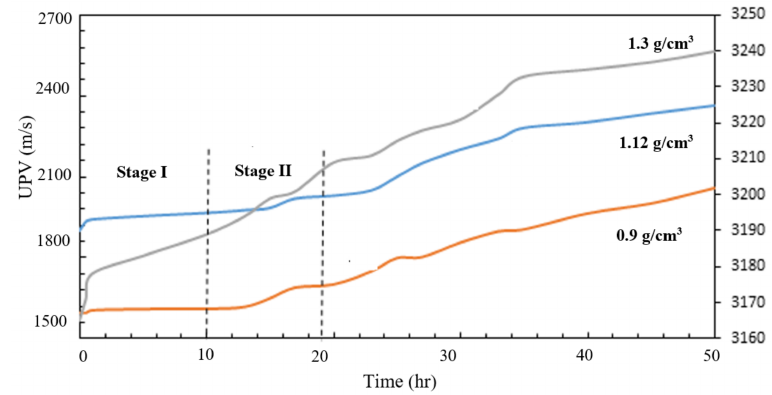
Figure 15. UPV time-history for aerated slurries of different densities.